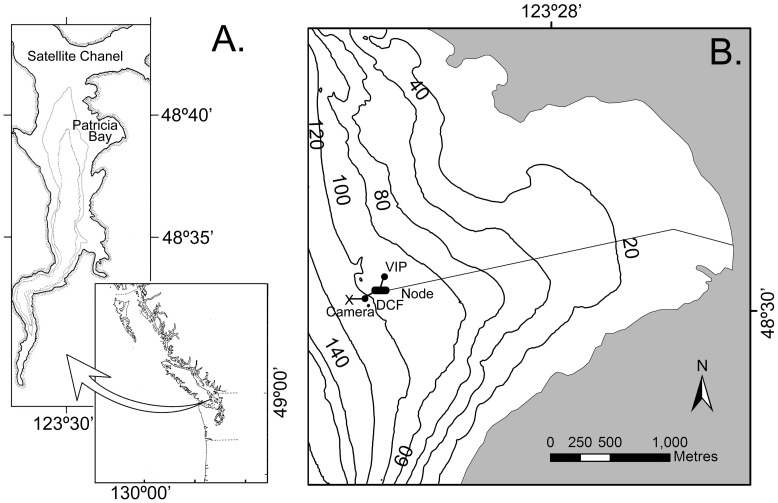
Study site.A. Saanich Inlet is on southern Vancouver Island, British Columbia on the Canadian Pacific coast. B. In Patricia Bay the Camera, located on a muddy bottom, was connected to a seafloor platform (DCF) that held the power controller and a CTD and O2 sensor; the Cable connects the VENUS Saanich Node to the Shore Station. The Node also serves the nearby instrument platform (VIP).